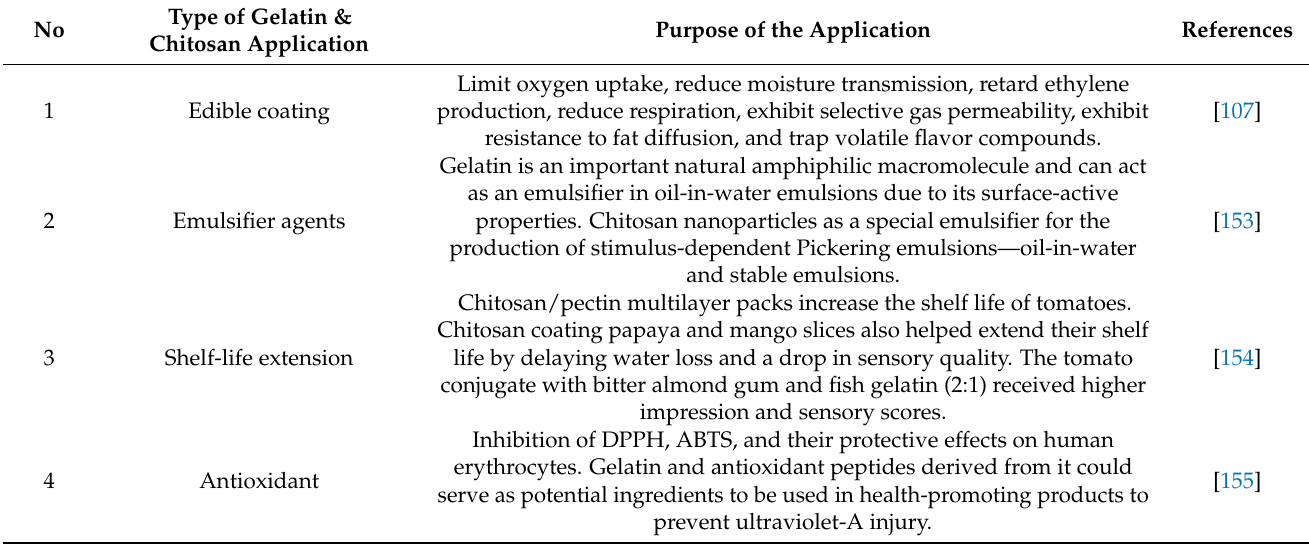
Table 1. Selected applications of chitosan in the food